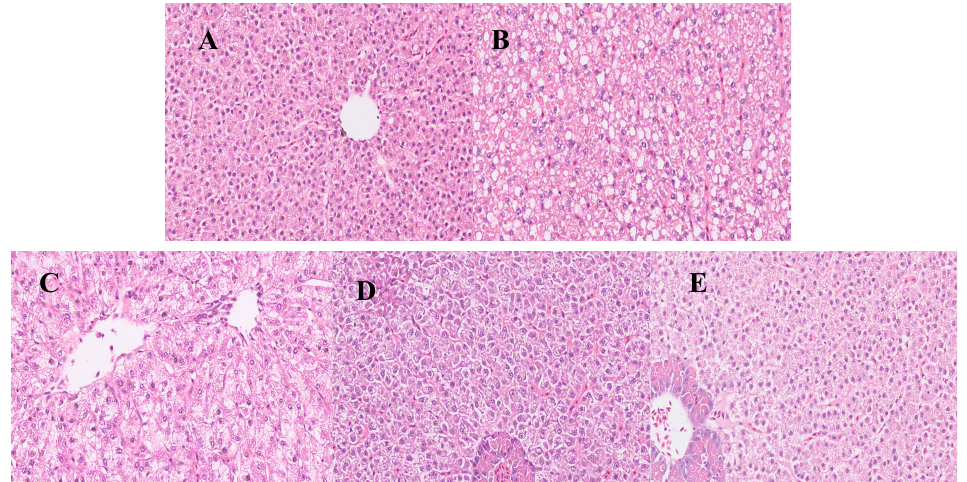
Figure 1. Effects of Sal B on histological changes in Nile tilapia liver sections. The liver sections were stained with haematoxylin and eosin. All sections were photographed with a microscope (400 × magnification): ( A ) normal saline alone; ( B ) CTX alone; ( C ) CTX plus 0.25 g · kg − 1 Sal B; ( D ) CTX plus 0.50 g · kg − 1 Sal B; ( E ) CTX plus 0.75 g · kg − 1 Sal